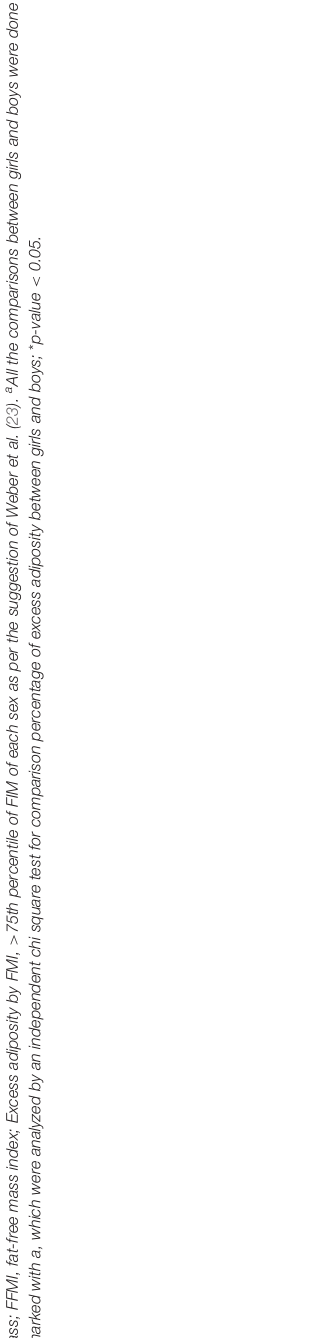
Table 3 provides a comparison of the CPF of patients categorized based on their BMI. Traditionally, patients with excessive BMI might have greater measured oxygen consumption at AT VO 2 and peak VO 2 value, indicating that a